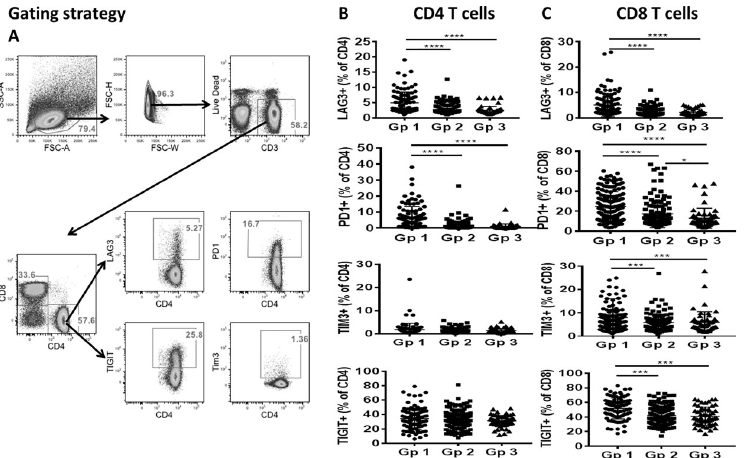
Fig 1. Higher frequencies of LAG-3, PD1, TIGIT and TIM3 on CD4 and CD8 T cells in ART na ï ve group. Checkpoint inhibitor (CPI) molecules and T cell immune activation markers were analyzed on CD4 and CD8 T cells by flow cytometry in ART na ï ve (Gp1) and virologically suppressed (Gp2) patients and healthy controls (Gp3). A), Representative flow cytometry dot plots showing gating strategy for the analysis of CPI on CD4 T cells. Frequencies of LAG-3+, PD1+, TIGIT+, and TIM3+ cells are shown in B), for CD4 T cells and C), for CD8 T cells. Line and error bars within the plot indicate the Mean ± SD. Data compared between groups using Wilcoxon rank-sum test. A p value < 0.05 was considered significant. � p < 0.05; �� p < 0.01; ��� p < 0.001; ���� p < 0.0001.